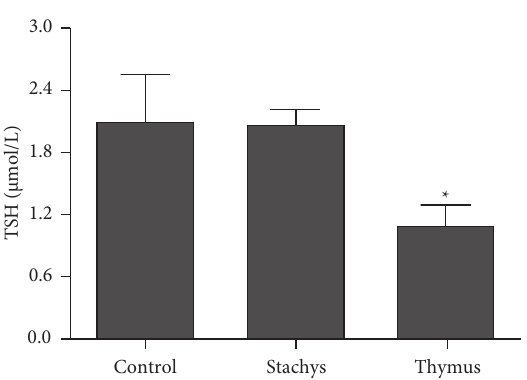
Figure 6: Effect of S. pilifera Benth and T. daenensis Celak extracts on total thiols (T-SH), for 24h in HepG2 cells ( ∗ P < 0 . 05, in comparison to the control).